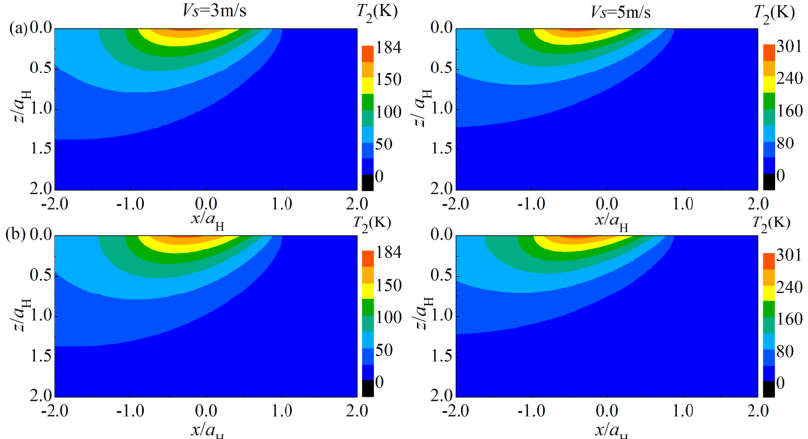
Figure 5. Comparison on the temperature rise in xoz plane between the present model and Chen’s model under different sliding speeds: ( a ) solution of Chen’s model, ( b ) solution of the present model. The comparisons conducted above not only validate the present contact model, but also show that the present model can be utilized to analyze the thermoelastic contact problem of homogeneous